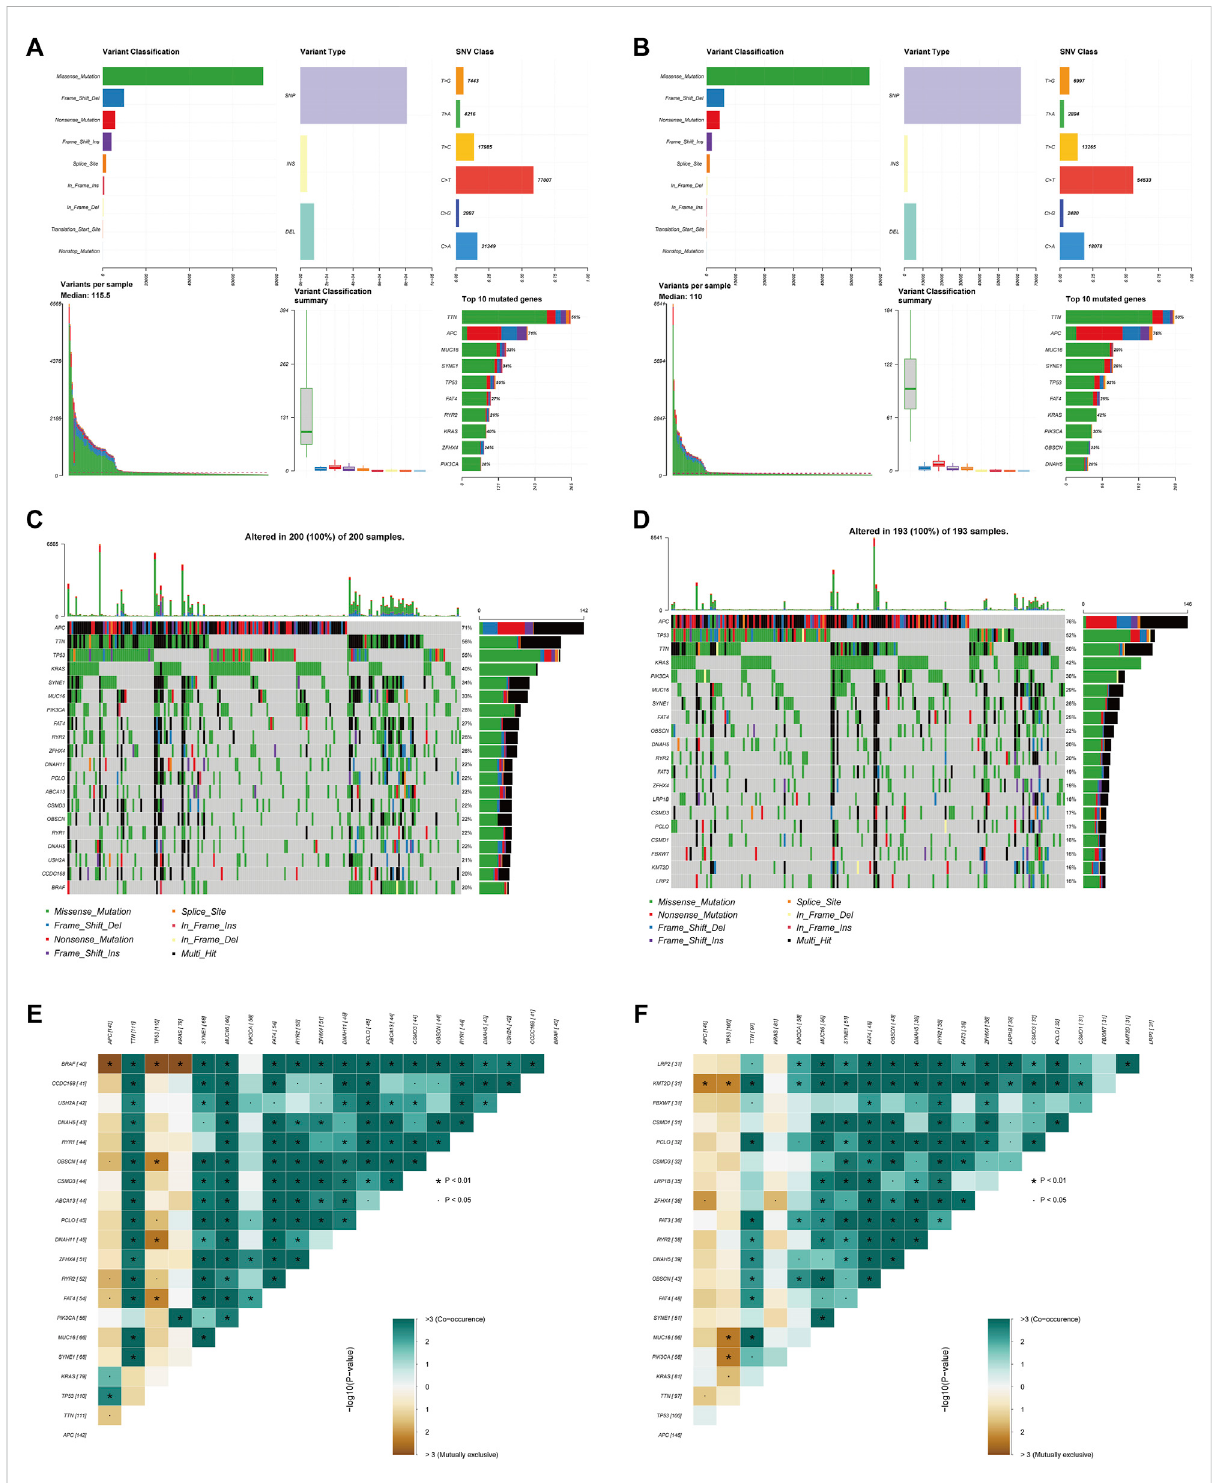
FIGURE 9 Somatic mutation analysis in the two subgroups. (A,B) Distribution of mutation types between the high-risk (A) and low-risk groups (B) . The upper panel depicts the variant classi fi cation, variant type, and SNV class of mutated genes, and the bottom panel represents variants per sample, variant classi fi cation, and the top ten mutated genes. (C,D) Waterfall plot of somatic mutations between the high-risk (C) and low-risk groups (D) . (E,F) Comparison of co-occurrence and mutually exclusive mutations of the mutated genes between the high-risk (E) and low-risk groups (F)